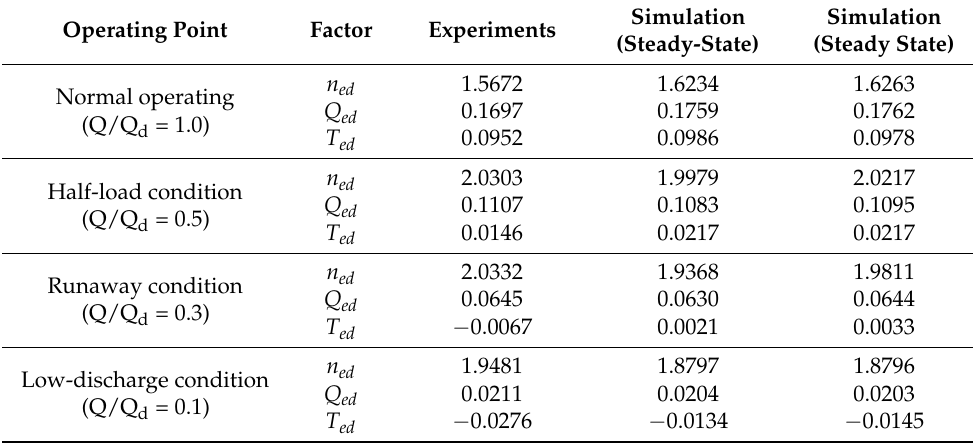
Figure 6. Comparison of performance characteristics between numerical simulations and experimental data in the full-scale model: ( a ) Turbine mode [20]; ( b ) pump mode [21]. Table 5. Validation of numerical simulation results at guide vane opening (GVO) = 21.5°.